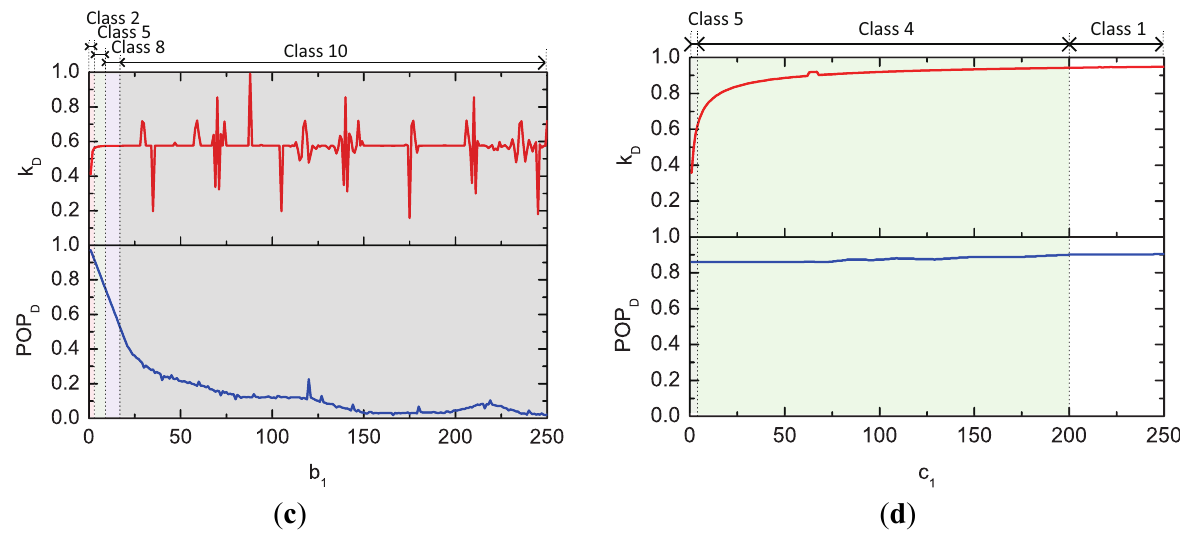
Figure 3. Effects of the changes in ( a ) M , ( b ) a 1 , ( c ) b 1 and ( d ) c 1 on k D , POP D and the k D -POP D class for the base model with M = 1, a 1 = 0.5, a 2 = 0, b 1 = 5, b 2 = 0, c 1 = 3 and c 2 = 3.